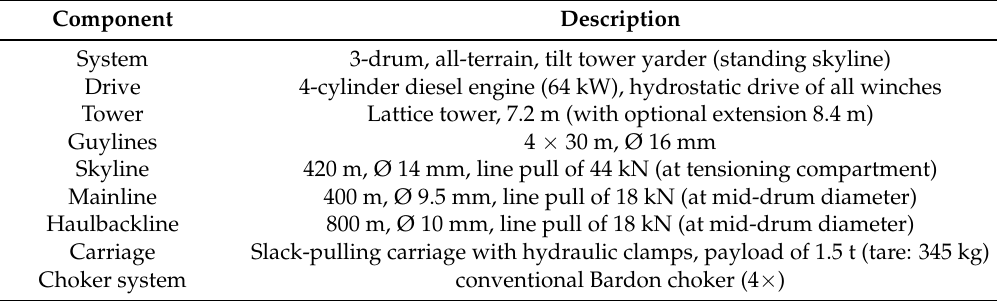
Table 2. Technical Description of the KOLLER K303 H Cable Yarder.